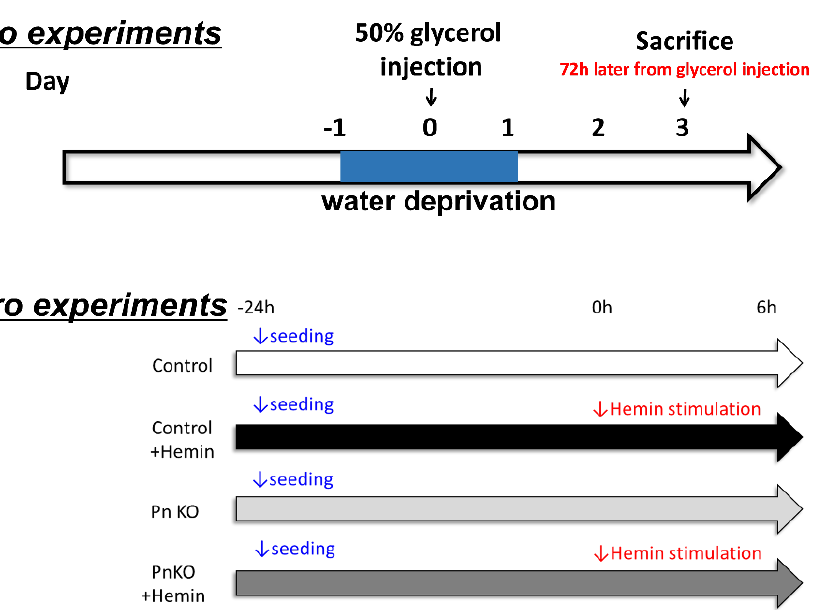
Figure 1. (In vivo experiments) The methods of the in vivo experiment schedule. 1. The day before the injection, the mice were abstained from drinking. 2. On the day of the injection, the mice were anesthetized by inhalation or intravenous injection, and 50% glycerol (diluted with normal saline) was injected into the thigh muscle. 3. The water deprivation was cancelled. 4. Acute renal failure due to rhabdomyolysis developed on day 3. (In vitro experiments) The methods of the in vitro experiment schedule. Cell: NIH3T3 fibroblast, medium: DMEM + 10% FBS, stimulus: Hemin (100 μM), stimulation time: 6 h, evaluation item: inflammation markers.